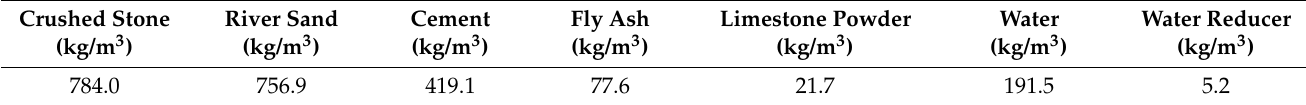
Table 2. Mix proportions of the test C40 concrete. (unit: kg/m 3